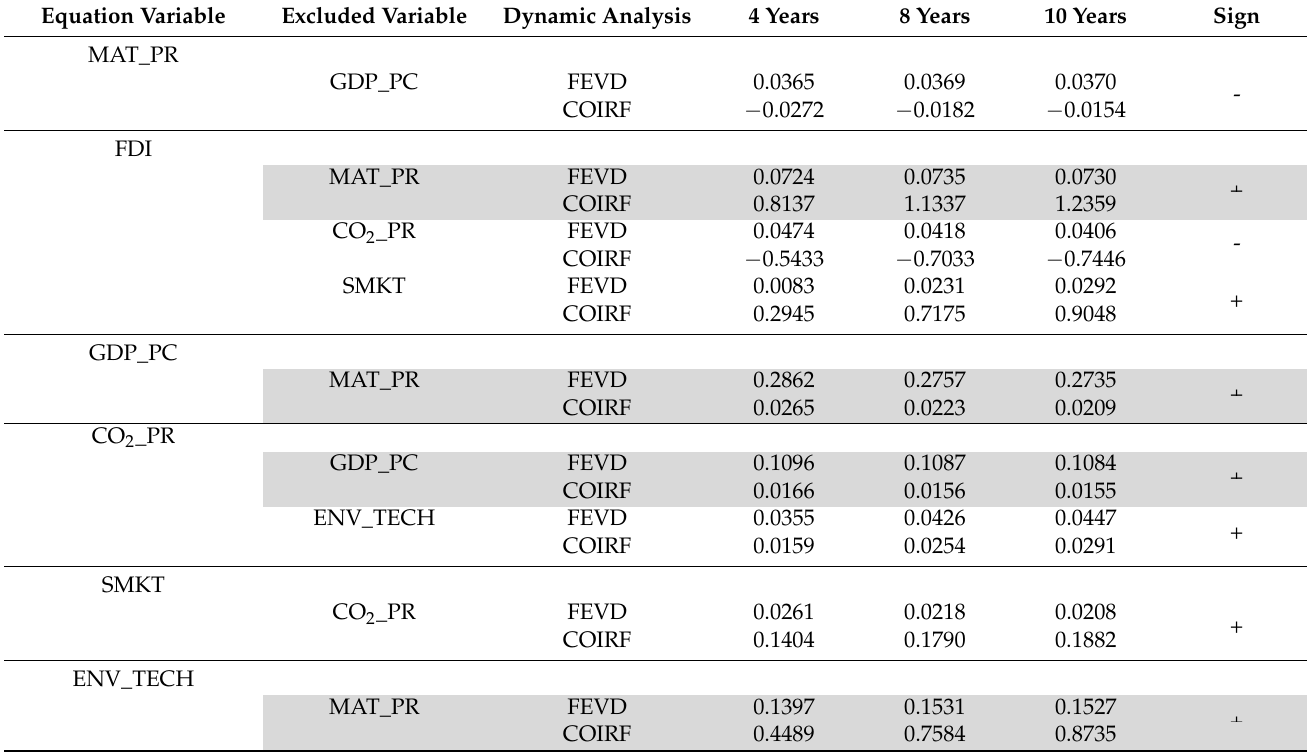
Table 6. Robustness test for the Global